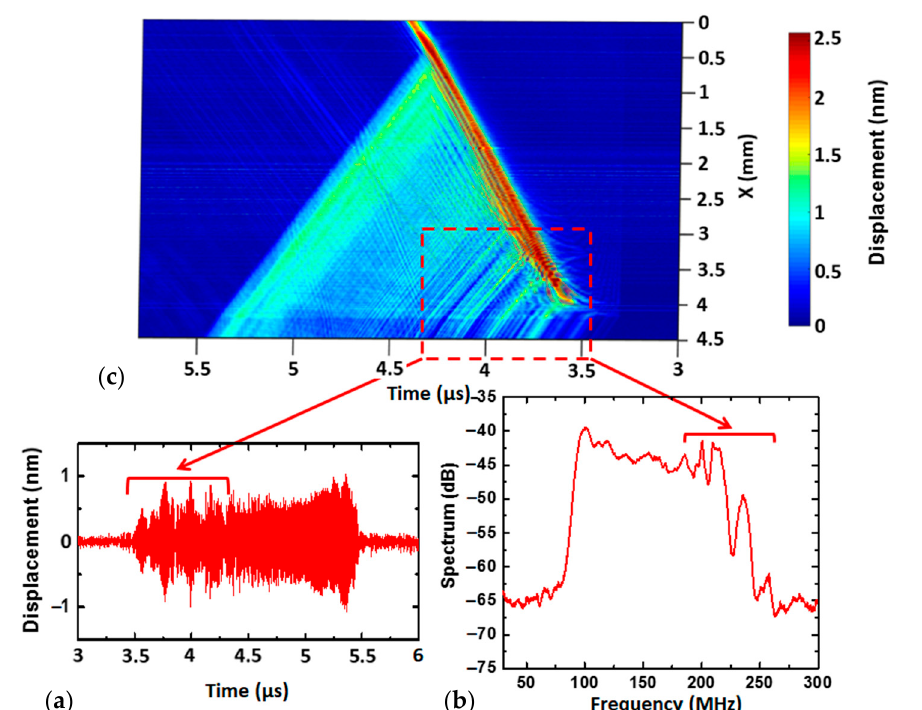
Figure 3. Optical measurement of SAW emission by the chirped IDT: ( a ) A-scan, corresponding to the displacement of the surface wave in the time domain; ( b ) spectrum of the same signal; ( c ) longitudinal B-Scan, revealing bidirectional emission, multiple reflections and the formation of the temporal envelope of the emitted wave packet.